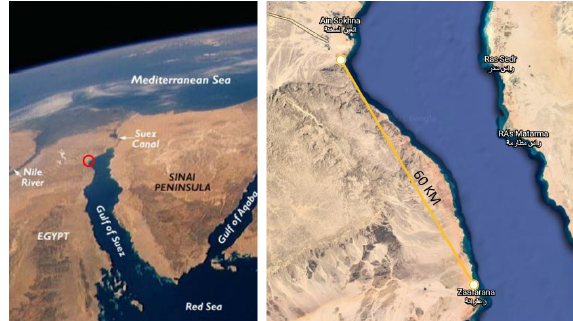
Figure 2. Map of Sinai, Gulf of Suez, and Sukhna – Zaafarana